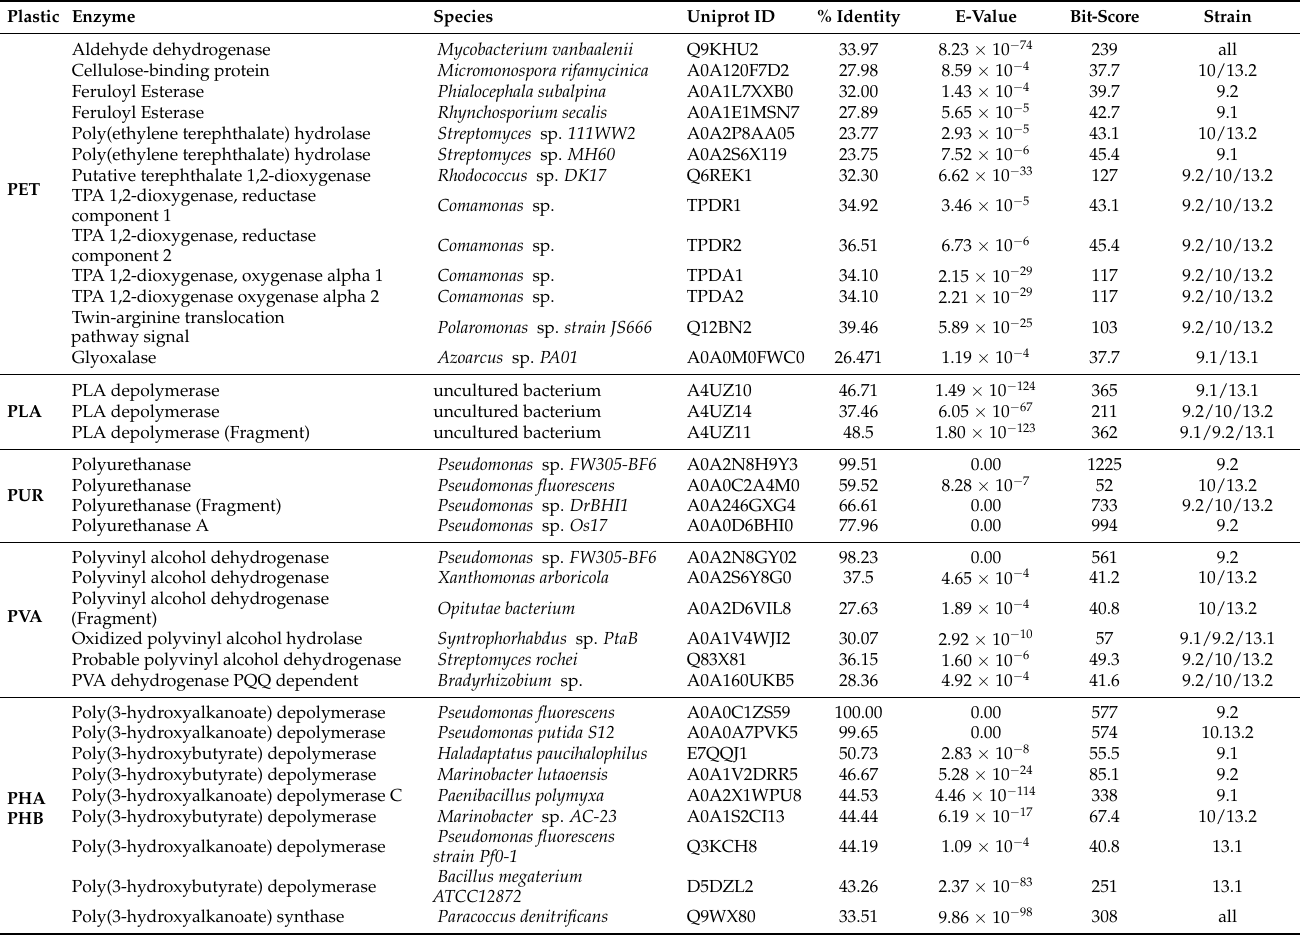
Table 1. Predicted plastic biodegradation enzymes with significant percentage identity and similarity to genes encoded within the pangenome of the full